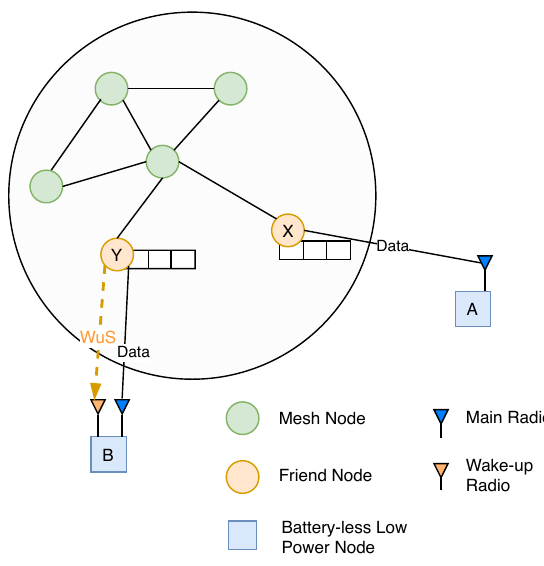
Figure 2. Overview of Bluetooth Low Energy (BLE) mesh network with integrated batteryless Low Power Nodes (LPNs), both with and without wake-up radio (WuR)